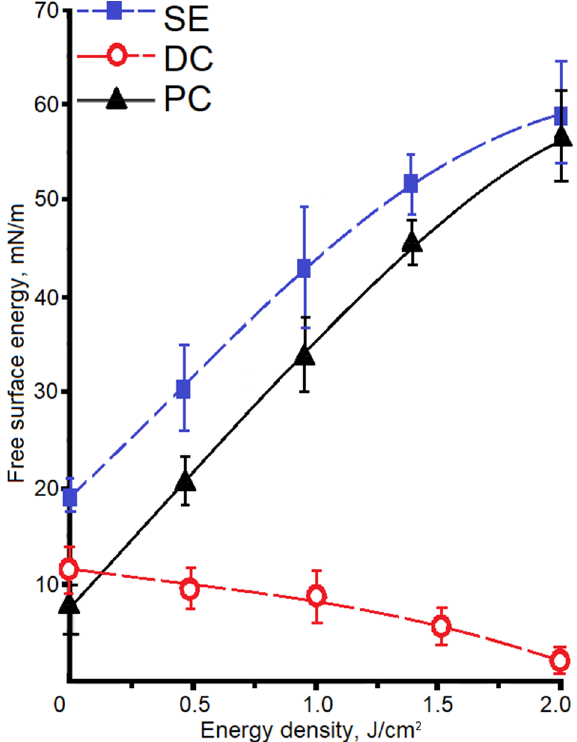
Figure 6. The FSE levels of the surface layers versus energy density (SE—total surface free energy, DC —dispersive component, PC—polar component).